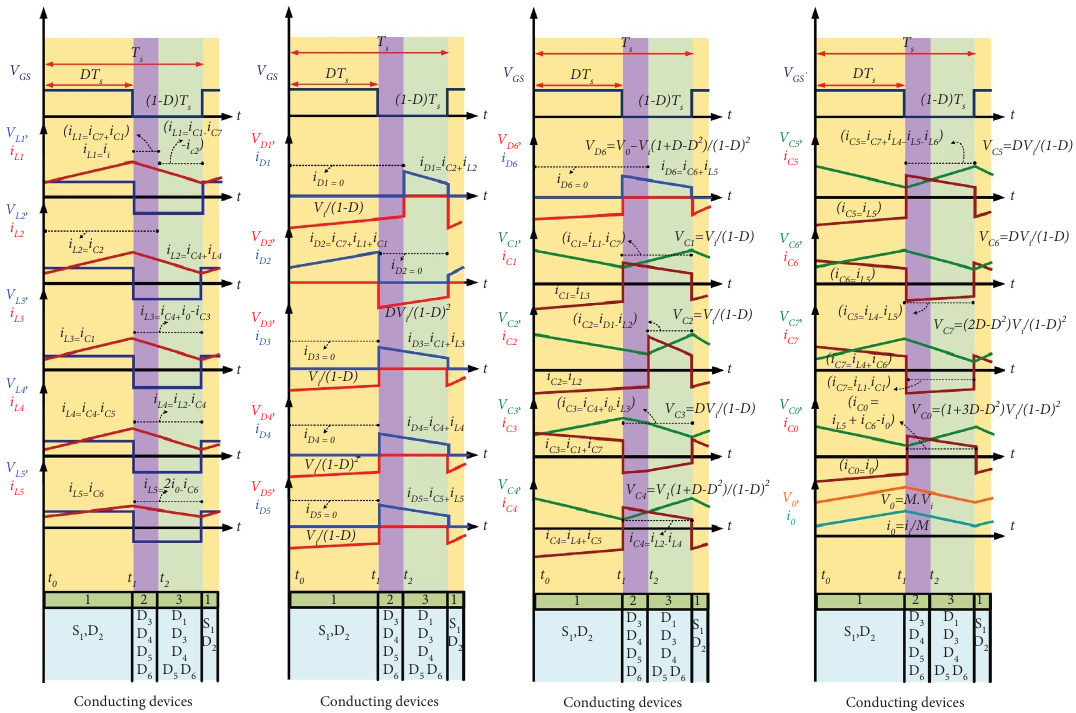
Figure 5: Analytical waveform of the proposed converter under CCM operation for one switching cycle.